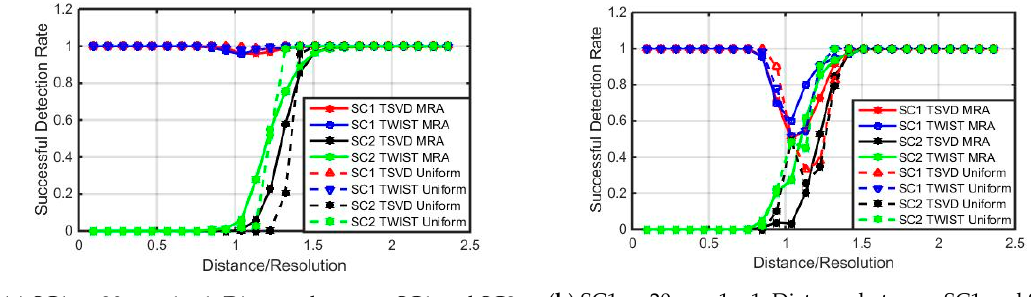
Figure 8. Successful detection rates of double scatterers when distance between both scatterers changes, where SC abbreviates from scatterer, γ is the normalized reflectivity (amplitude).